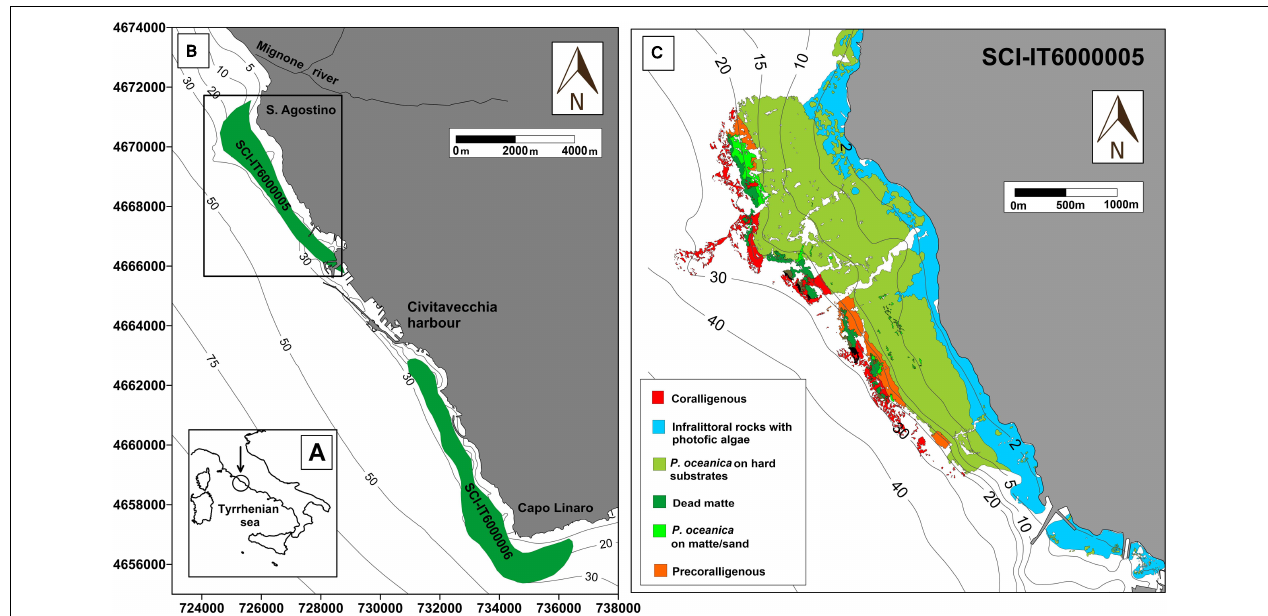
FIGURE 1 | Study area of the CAR project. Map of the sampling location at low (A) and high (B) magnification. All fish and algae sampling occurred exclusively within SCI 6000005 (black frame), which extends from Punta S. Agostino to Punta della Mattonara. SCI 6000006, because of its proximity to the area, is also indicated on the map. (C) Thematic map of the distribution of benthic biocenosis in the study area.